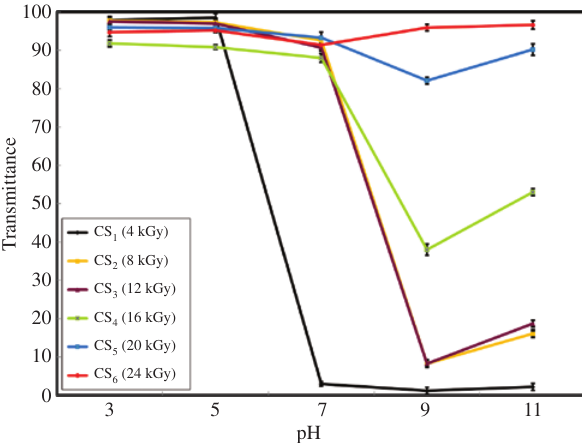
Figure 4: pH dependence of the water-solubility of chitosan with different molecular weights: CS = 7.05 kDa), CS (M w = 4.07 kDa), CS (M w